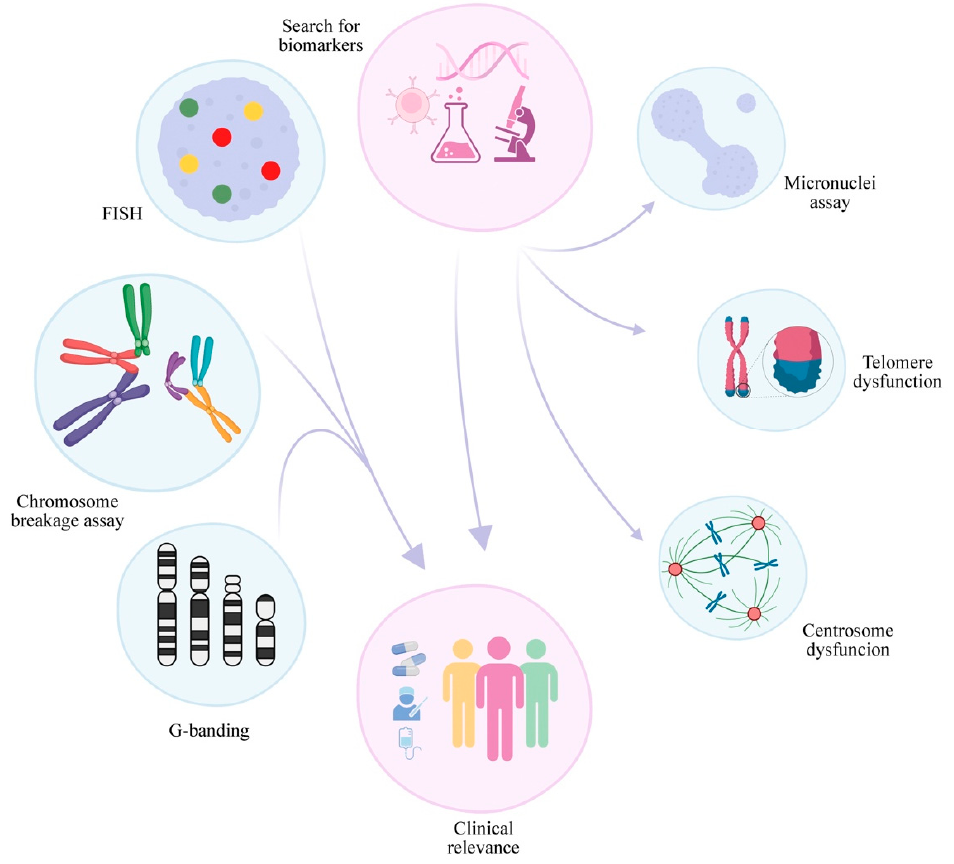
Figure 2. Cytogenetics in FA: summary of conclusions and future perspectives. The progress of cytogenetics in FA in recent decades has led to the establishment of CBA breakage as the “gold” standard which, combined with classical and molecular cytogenetics, provides valuable information for patient management and treatment. The search for new biomarkers in FA and a better comprehension of those already identified, including abnormalities in binucleated cells generated in the micronuclei cytome assay and telomere dysfunction, may lead to a better understanding of the disease and provide better treatments in the future.